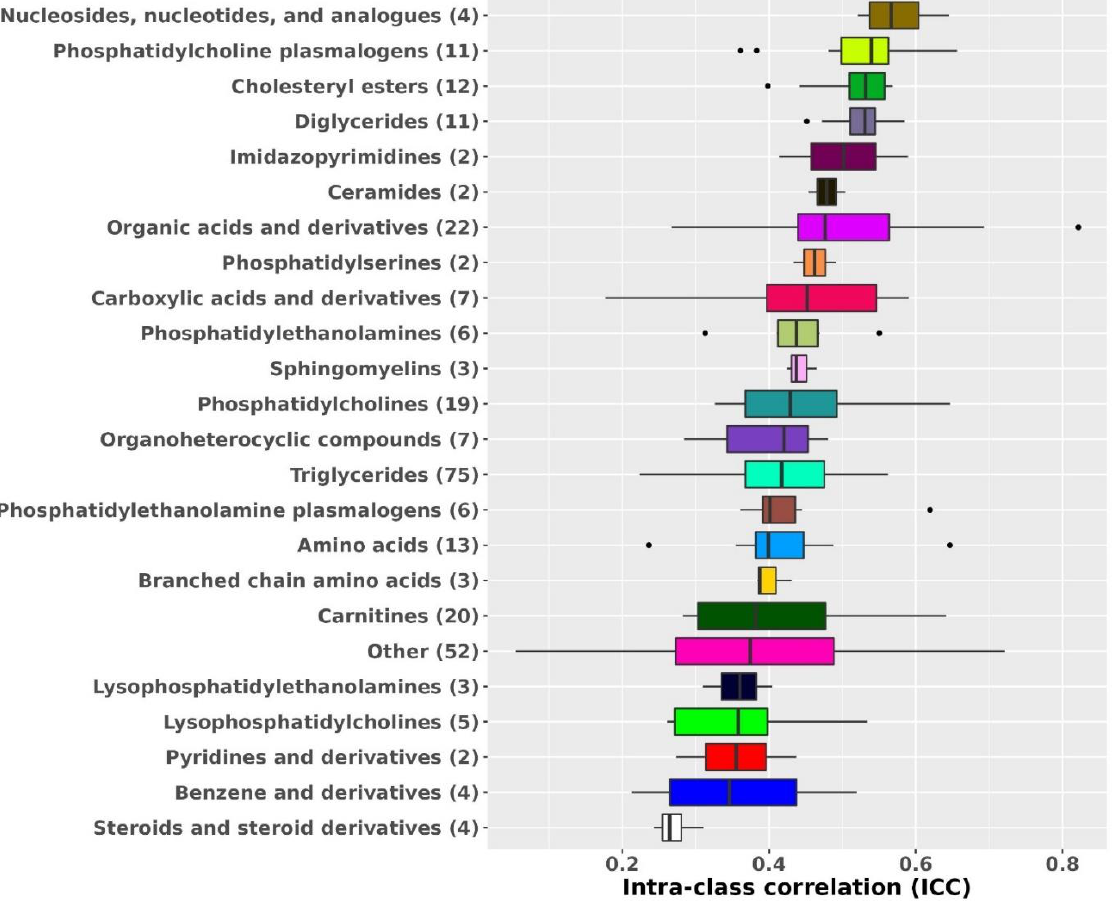
Figure 1. Metabolomic profiles stability over 10 years by metabolite class. Results from known metabolites are included in this figure. Metabolite classes with less than two metabolites were added to the class Other. ICCs beyond the whiskers (outliers) are plotted individually as black dots. The left whisker extends from the left hinge of the box (25th percentile) to the smallest value but no further than 1.5*IQR (inter-quartile range). The right whisker extends from the right hinge of the box (75th percentile) to the largest value but no further than 1.5*IQR (inter-quartile range).